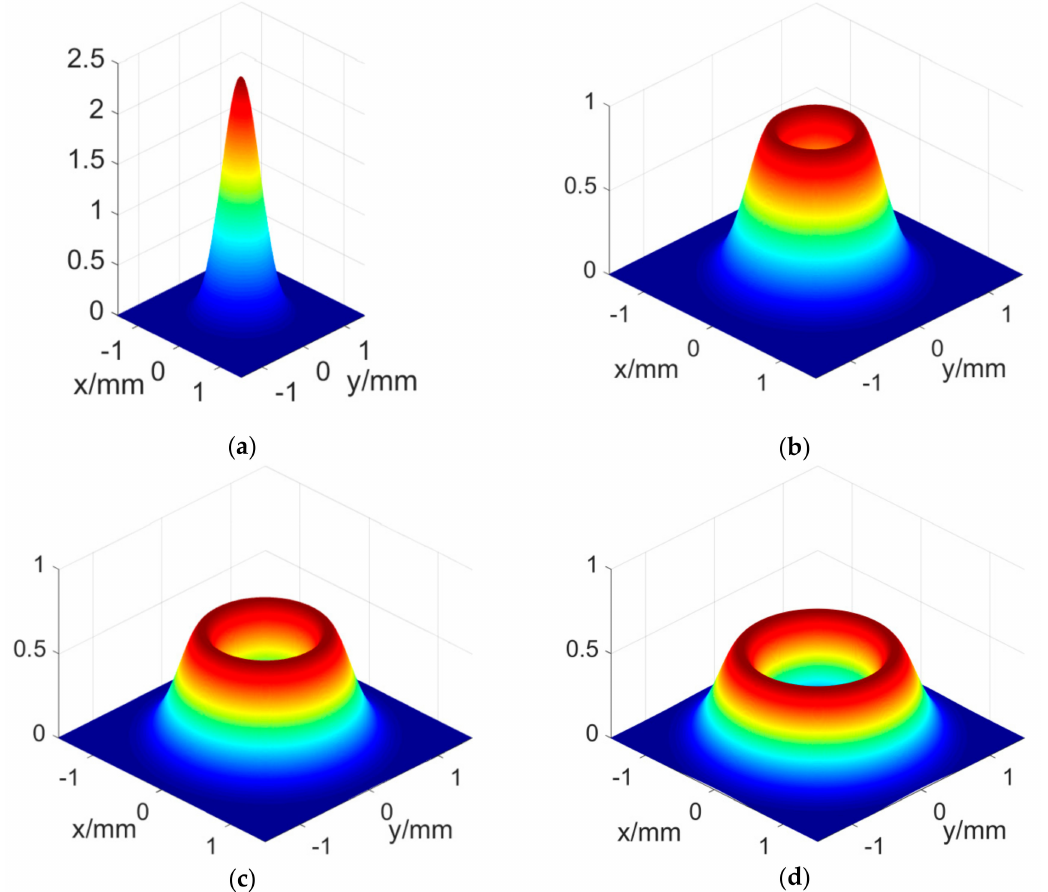
Figure 1. Power intensity distribution of the L-G beams ( K = 1, ω = 0.65 mm ), ( a ) p = 0, l = 0, ( b ) p = 0, l = 1, ( c ) p = 0, l = 2, ( d ) p = 0, l =